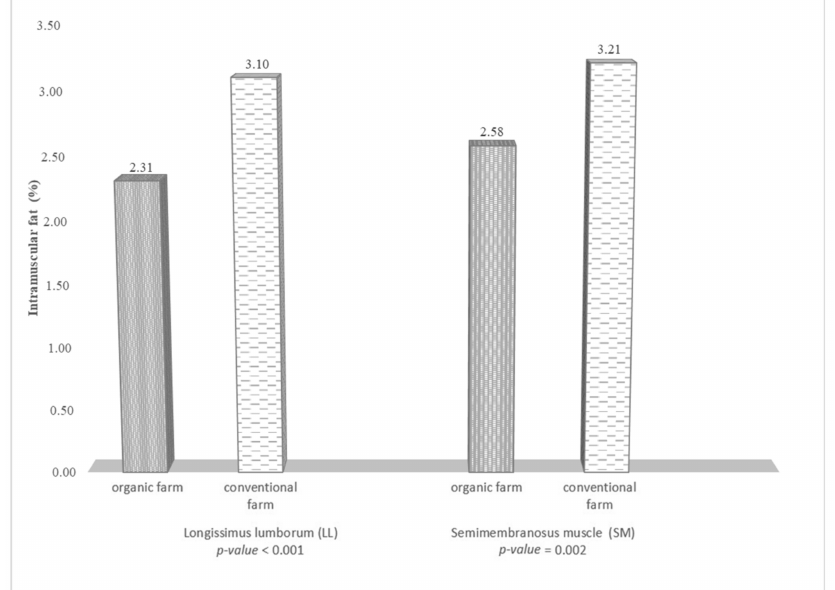
Figure 1. Intramuscular fat content (%) in the meat of fallow deer from organic and conventional farms.